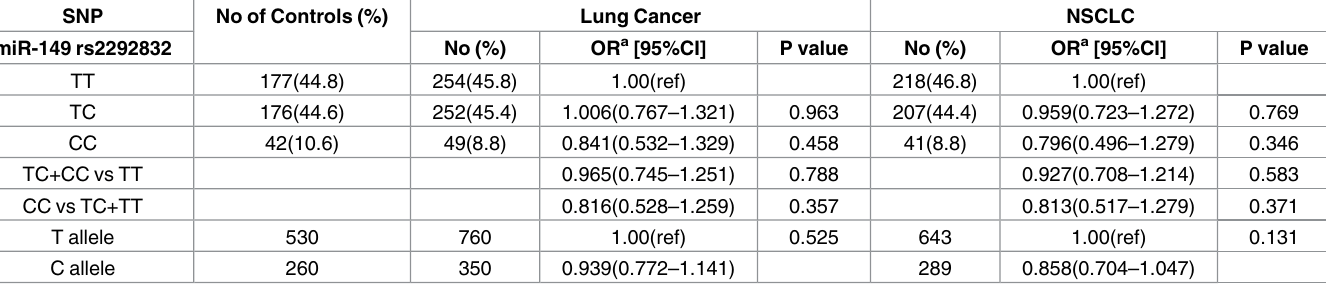
Table 2. Distributions of rs2292832genotypes and alleles in two groups and their associations with risk of lung cancer and non-small cell lung cancer.